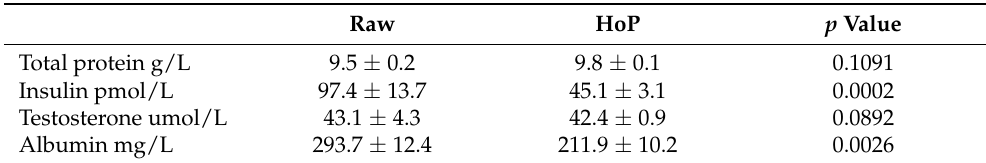
Table 3. Impact of Holder pasteurization on the concentrations of insulin and testosterone in donor milk ( n = 96). Raw HoP p Value Total protein g/L